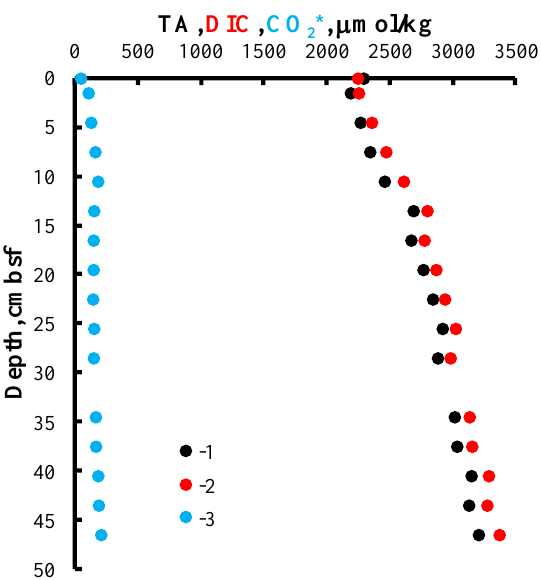
Figure 8. Vertical profiles of TA (1), DIC (2) and CO 2 * (3), μ mol/kg. CR41 station. The effect of the composition of the ionic medium on the stoichiometric constants of carbonic acid and carbonate minerals is an important issue for accurate calculations of the carbonate system in porewaters. This effect can be taken into account by empirical equa- tions relating the values of the stoichiometric constants to the prevailing salinity [55,56]. Such a simplification is possible because concentrations of the major constituents of sea- water exhibit almost constant ratios to one another throughout the oceans [52]. However, relative concentrations of the major constituents are widely variable in the porewaters of marine sediments due to the early diagenesis of organic matter, which occurs in these often anoxic environments (sulfate reduction, mineral dissolution, and precipitation). There- fore, the dissociation constants obtained in seawater cannot be applied for the description of the carbonate system in anoxic marine sediments and other seawater environments with anomalous major ion concentrations, as was noted elsewhere [74,75]. In our case, the studied sediment cores were not long; therefore, the chemical anomalies of the major constituents of the porewater were not large. Nevertheless, we took into account the effect of the variability of major ion concentrations on dissociation constants using the Pitzer method [49,50]. Using the available Pitzer’s parameters, the empirical relationships were developed for estimation variations in pK 1c , pK 2 , and sp, caused by variations in the major ion concentrations (Equation (S22)–(S27); Supplemental Material). The order of variabil- ity of calcium concentrations in our case is approximately 0.2 mmol/kg (Table S1). This anomaly according to Equations (S22)–(S24) results in ∆ pK 1 , ∆ pK 2 , and ∆ sp as 0.00025, 0.0068, and 0.01, respectively at t = 0 ◦ C, S = 34 psu. The maximum variation in hydrocar- bonate and sulfate anion concentrations in the porewaters were 2 mmol/kg and 1 mmol/kg, respectively (Figure 7; Equation (S15)). These anomalies provide uncertainties in ∆ pK 1 , ∆ pK ∆ sp of 0.0014, 0.0047, and 0.0004, respectively at t = 0 o C, S = 34 psu. These 2 , and uncertainties are less than the experimental errors of the equilibrium constants and can be